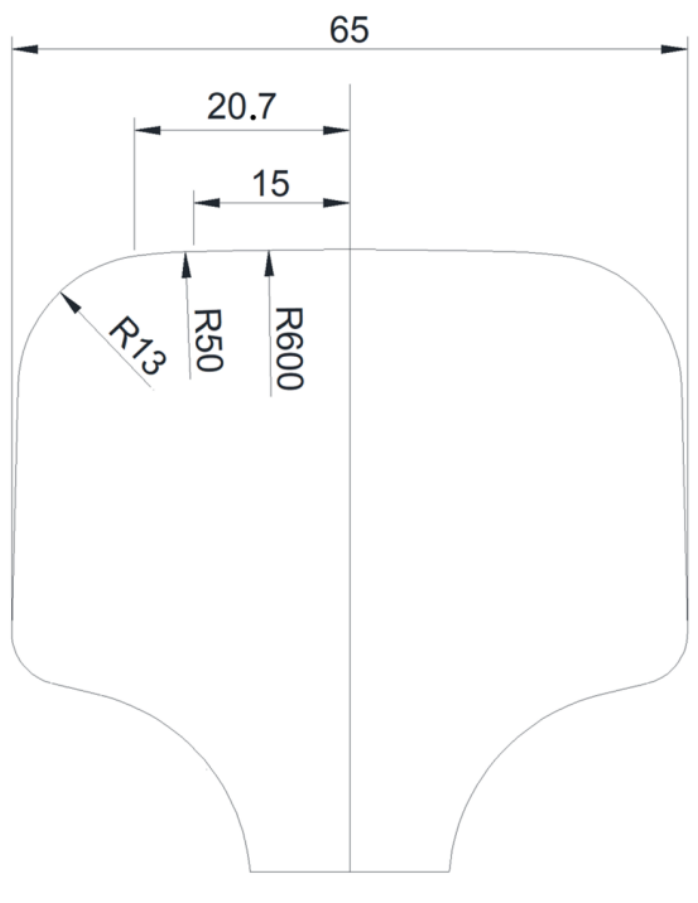
Figure 3. Rail profile of KS60.